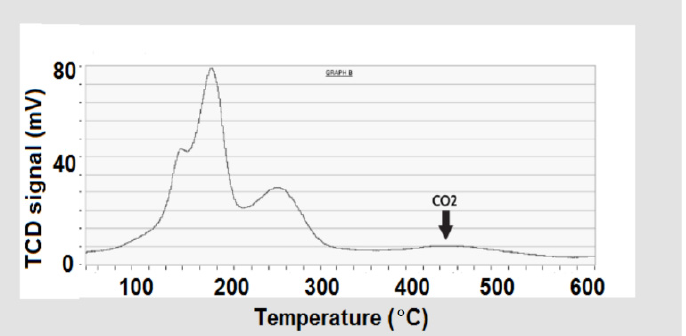
Figure 9. TPO profile on the spent catalyst.